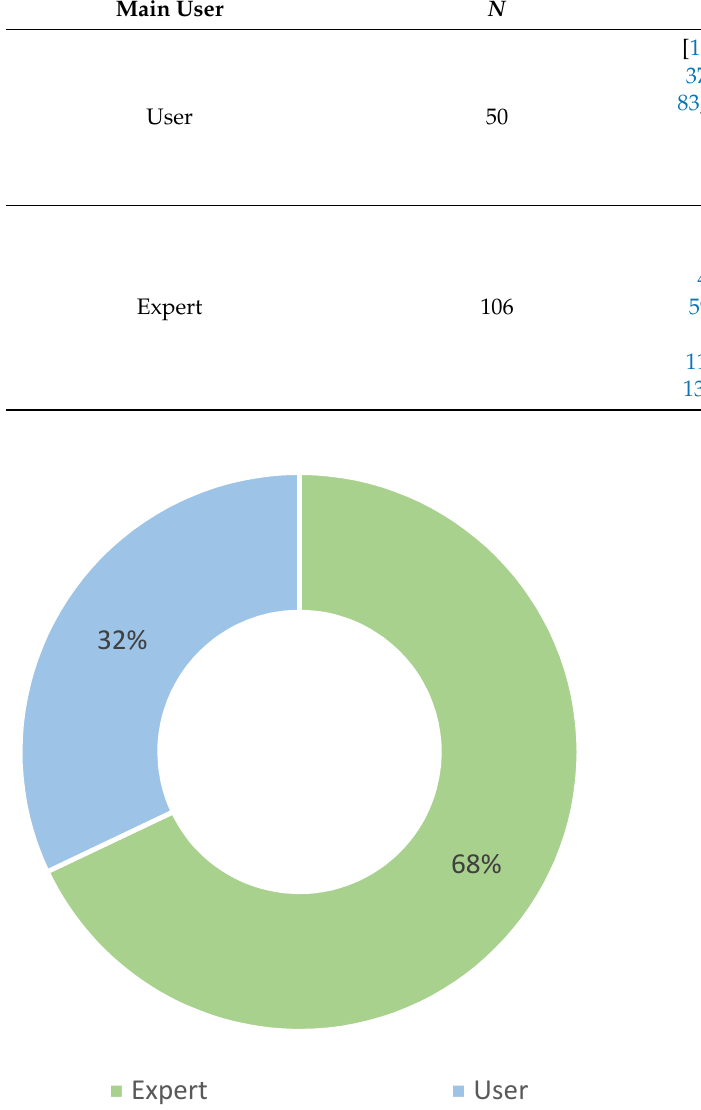
Figure 13. BMF applications prevalence according to the primary user. Table 10. Intended BMF application use environment.